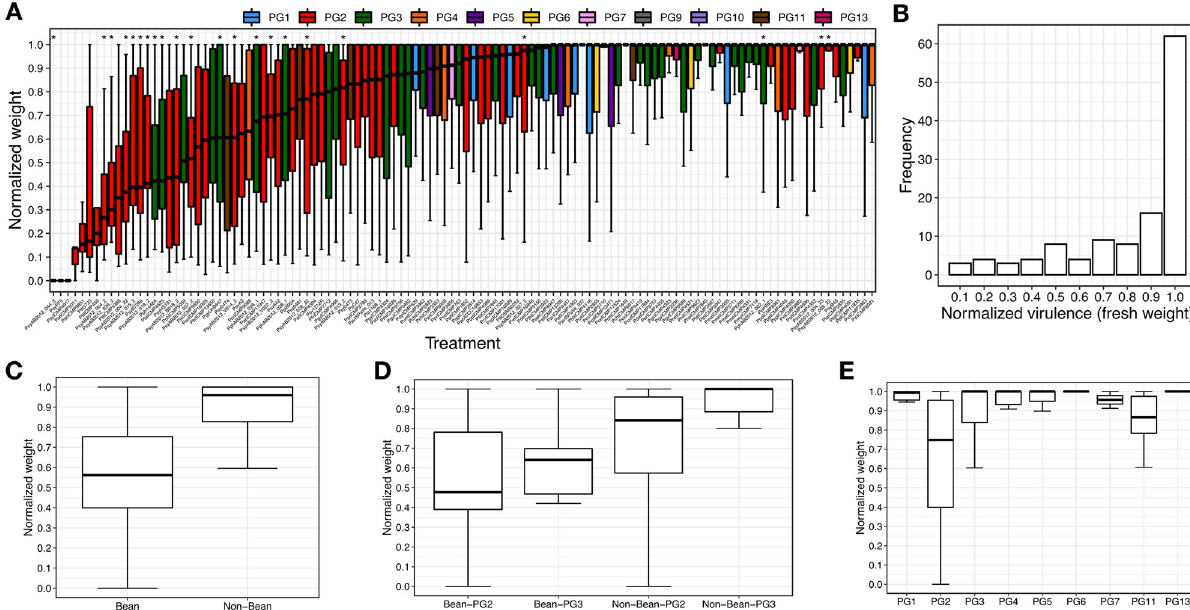
Fig 4. Virulence stratified by host and phylogroup. (A) Boxplots showing the distribution of virulence (i.e., normalized plant weight 14 days after seed infection) ordered by the median virulence. Colors correspond to phylogroups as shown along the top. Bean isolates are indicated with asterisks above their respective boxplots. (B) Frequency plot of virulence for the 121 screened P . syringae strains. Distribution of virulence values for (C) bean verses non-bean isolates, (D) bean and non-bean isolates stratified by phylogroup, and (E) virulence values stratified by phylogroup (PG) for the set of 121 screened